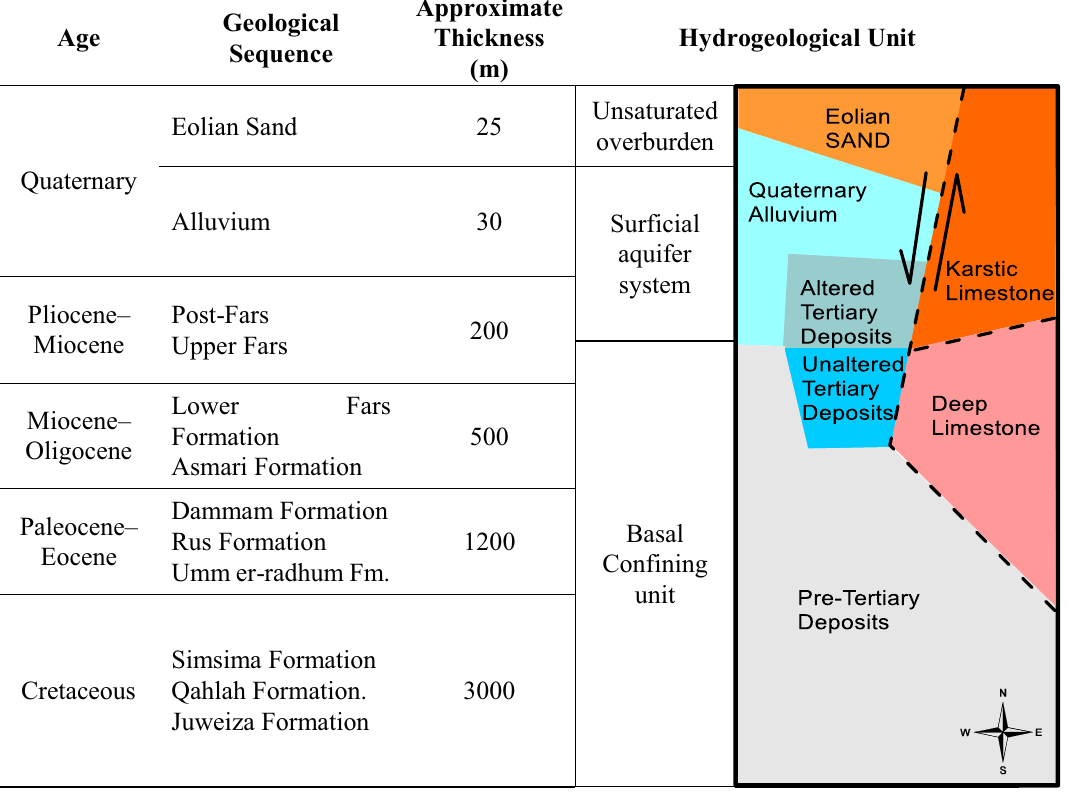
Table 1. Hydrogeological framework of the eastern part of Abu Dhabi Emirate (Hutchinson, 1998).